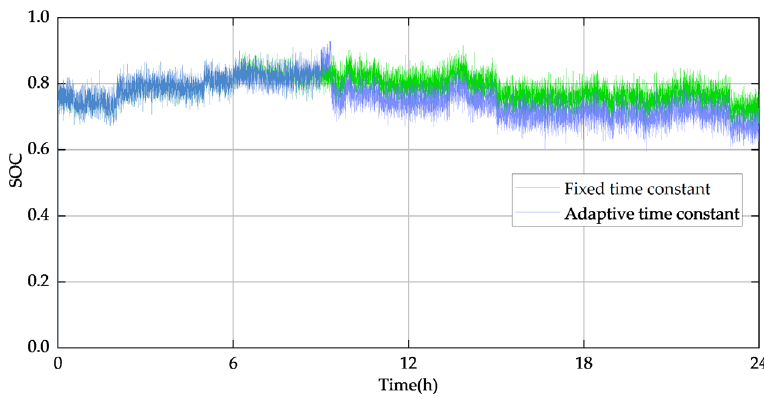
Figure 16. The change in SOC Ba before and after the change in time constant.